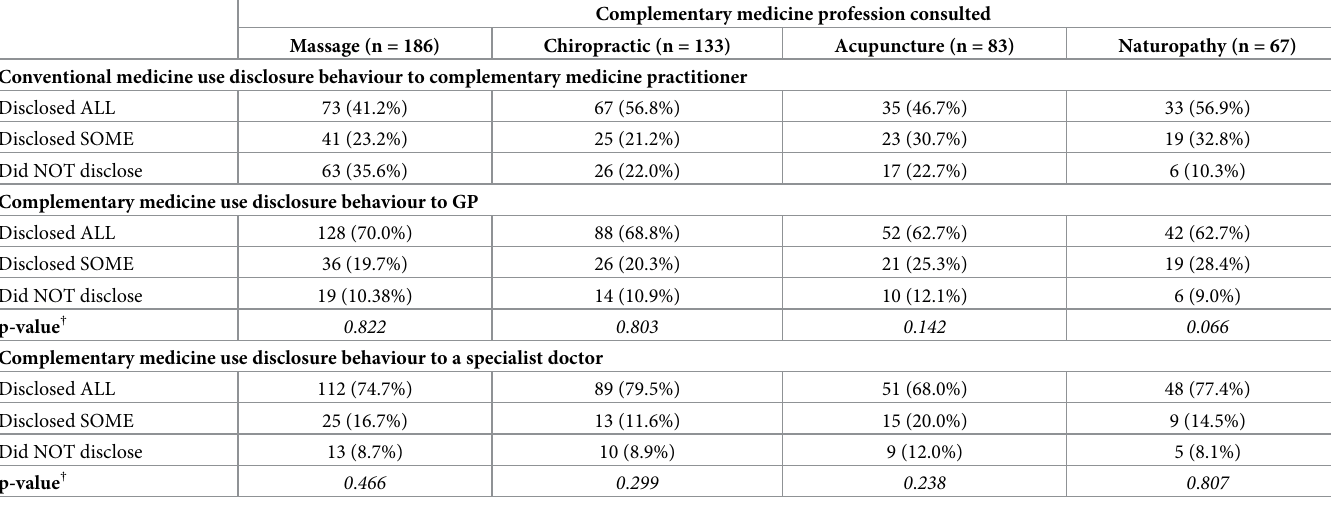
Table 2. Rates of disclosure behaviour types to complementary medicine practitioners, GPs and specialist doctors, including differences in type of disclosure to GPs and specialist doctors between complementary medicine professions